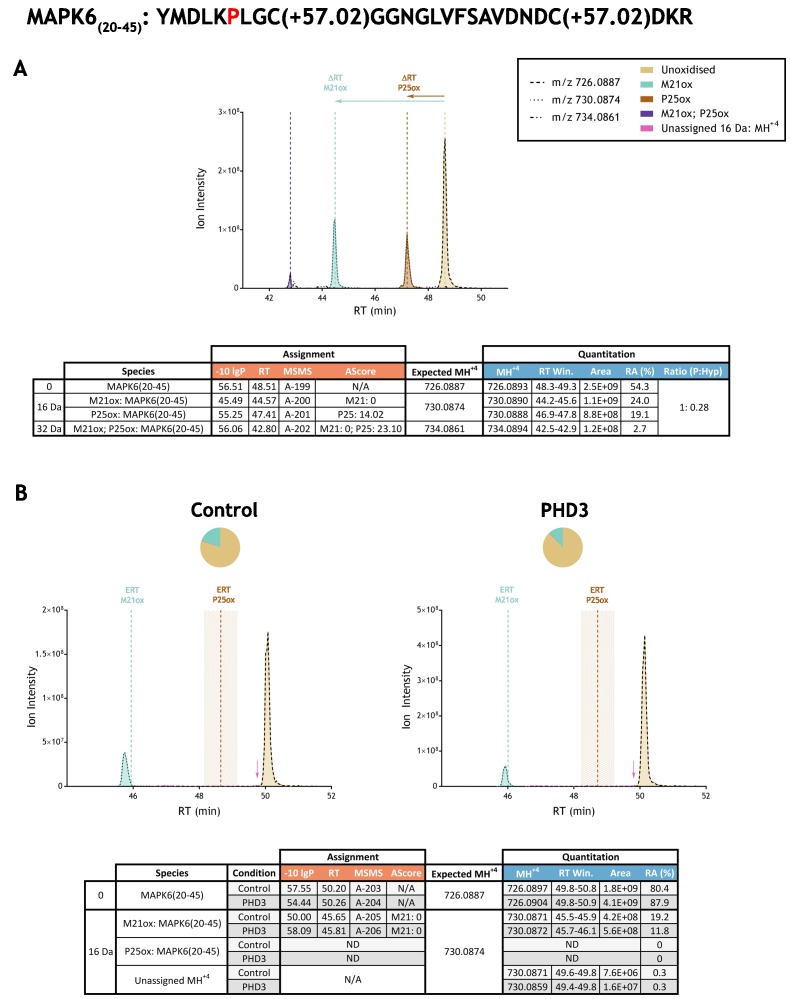
Example of quantitation of peptide oxidation on IVTT substrates reacted with PHD enzyme by extracted ion chromatogram (XIC).(A) Shows ion intensity and retention time (RT) characteristics of equimolar synthetic peptide standards for unoxidised and P25ox forms of the tryptic MAPK6(20–45) peptide. MSMS assigned species including non-enzymatic oxidations are coloured (see inset); vertical dashed lines define peak maxima used to derive ΔRT values for key oxidised ions. (B) Shows comparable XIC data for protease-digested IVTT substrates under control (left) or PHD3-reacted (right) conditions. Peaks corresponding to unoxidised and M21ox forms of MAPK6(20–45) were assigned by MSMS (see inset for colour code); P25ox was not detected. Estimated RT (ERT) values for oxidised peptides, derived from (A), are indicated by dashed vertical lines, shading applied to ERT P25ox corresponds to a 1 min RT window. Peptide ions of low abundance that were compatible with oxidation but not assigned by MSMS are also indicated (pink arrow). Quantitative data for observed species are presented as pie charts with XIC data. Assignment and quantitative data is provided below each panel as follows: (−10lgP) significance score of leading assignment at given (RT) with ambiguity score (AScore) for PTM localisation and reference to primary MSMS data in Supplementary file 1. Quantitative data reports ion counts (Area) of observed masses (MH+4) integrated over time (RT Win.), expressed as relative abundance (RA). Data on detection efficiency for synthetic peptides (Panel A, P: Hyp) is an aggregated ratio of prolyl (P) to hydroxyprolyl (Hyp) species.